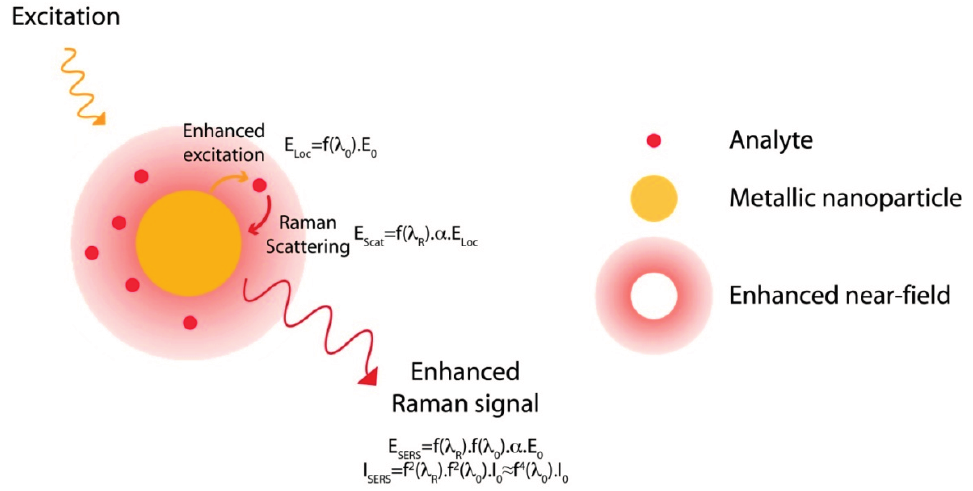
Figure 8. Principle of the Surface Enhanced Raman